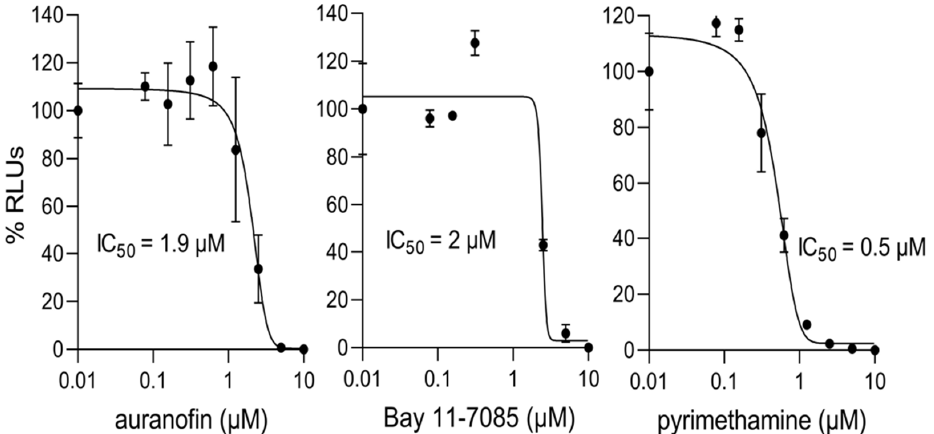
Figure 7. Auranofin and Bay 11-7085 inhibit T. gondii in vitro at low µM concentrations. HFF cells infected with RH-Fluc parasites were incubated with increasing concentrations of the indicated compounds for 48 h. Parasite growth was measured using a luciferase assay. Results shown above are from a single typical experiment performed in duplicate (SD indicated), from a series of three independent experiments (see Table 3, right column, for pooled data). Table 3. Summary of the IC 50 values for inhibition of P. falciparum and T. gondii parasites by IMP α inhibitors in culture.